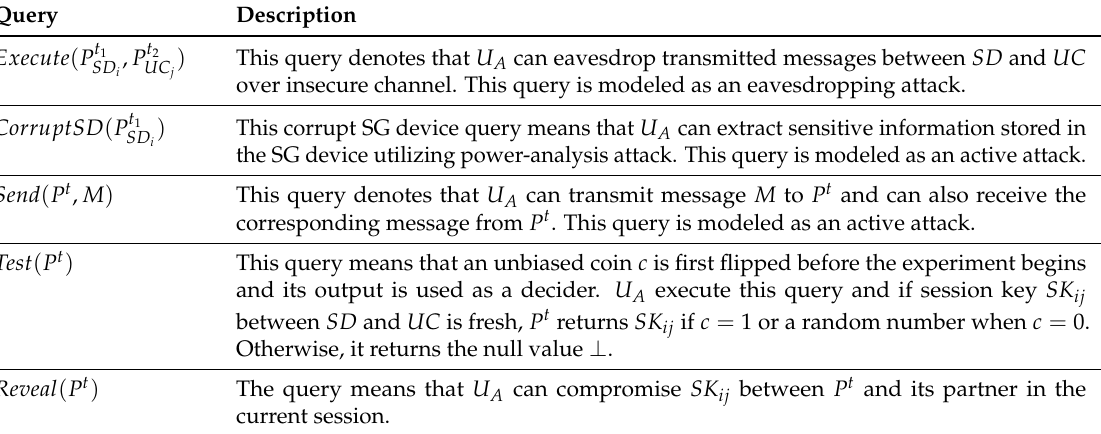
Table 4. Queries of ROR